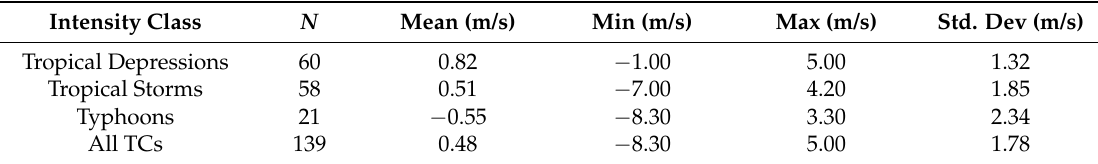
Table 5. Statistical results of intensity changes (ΔV) for tropical depressions, tropical storms, typhoons, and all TCs. N is the number of TCs. The mean, standard deviation (std. dev), minimum (min), and maximum (max) of ΔV are also provided.